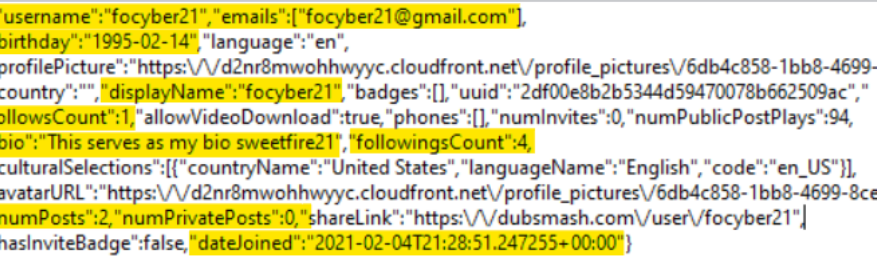
Figure 15. Profile details for Dubsmash user recovered from